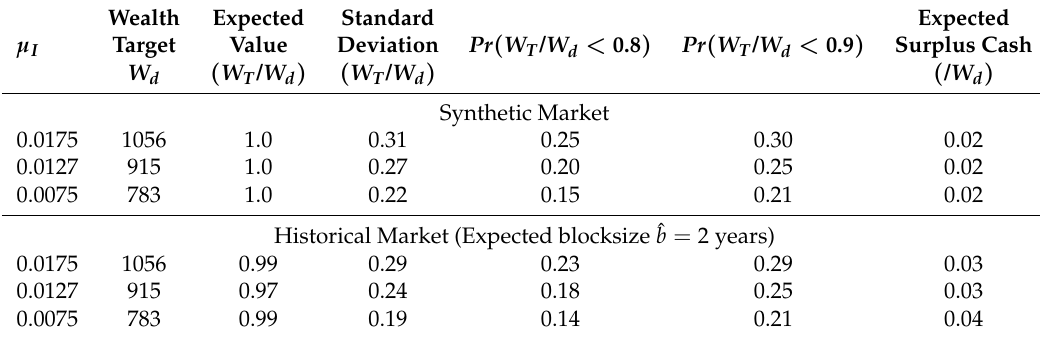
Table 6. Effect of varying salary escalation rate µ I for the QS optimal strategy. Units for W d : thousands of dollars. Remaining wealth values are normalized by W d for each case. Input data provided in Tables 1 and 2, except as noted. Synthetic market results computed using Monte Carlo simulations with 160,000 sample paths. Historical market results based on 10,000 bootstrap resampled paths